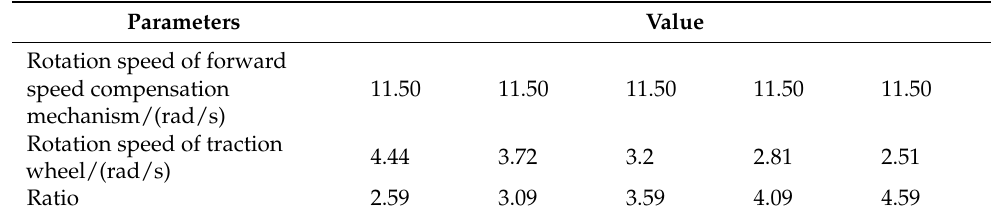
Table 4. Rotation speed ratio.